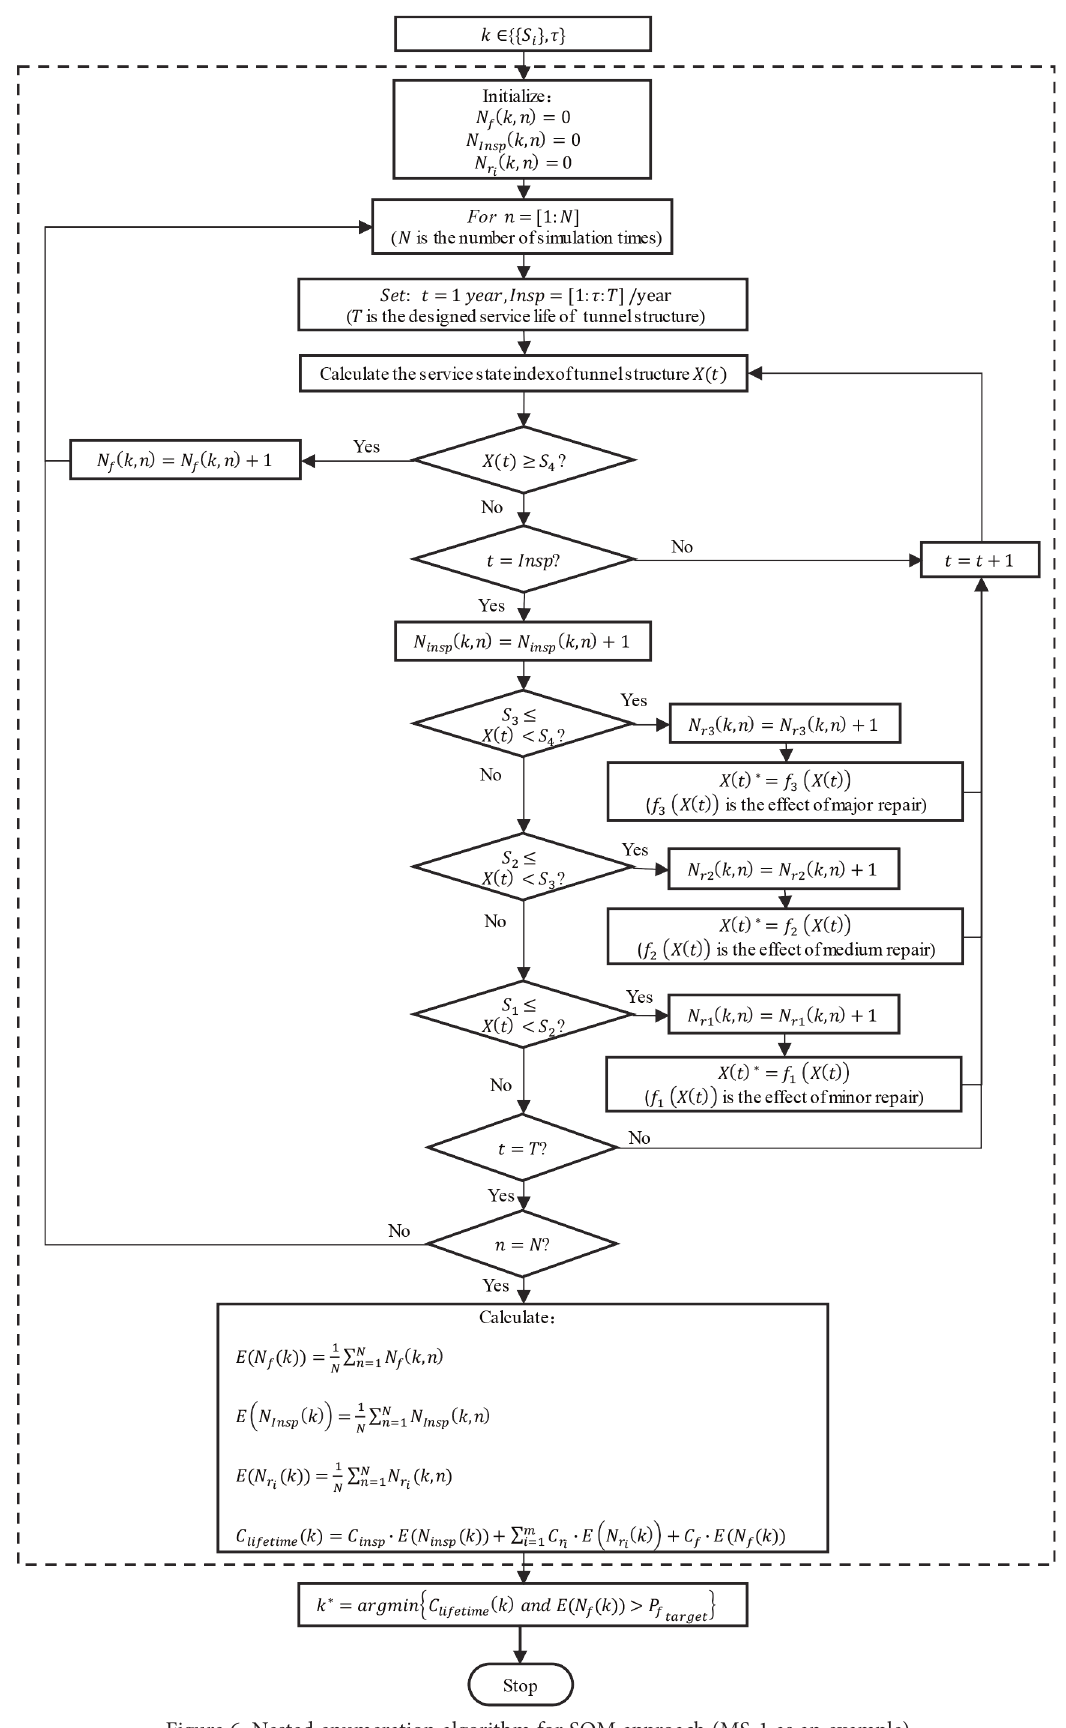
Figure 6. Nested enumeration algorithm for SOM approach (MS-1 as an